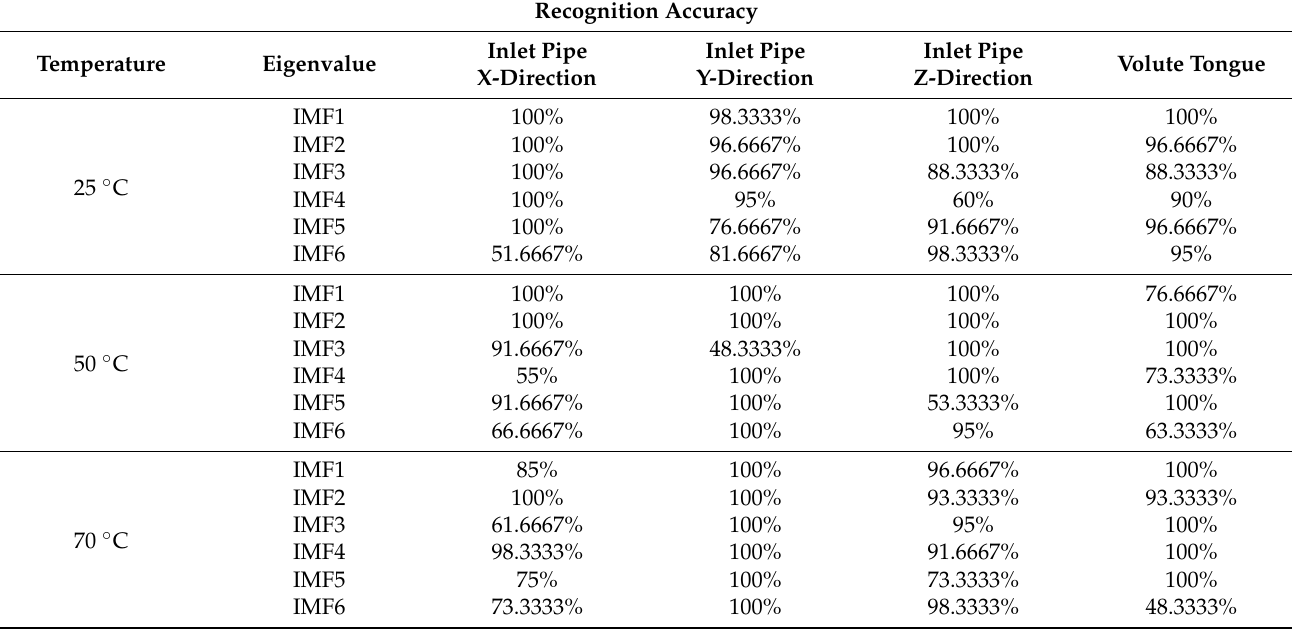
Table 3. Accuracy of time frequency domain eigenvalue